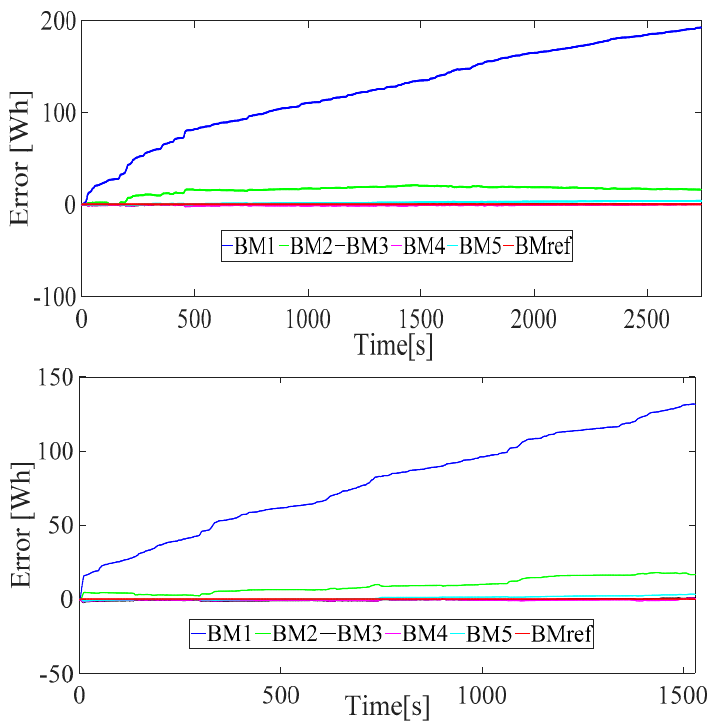
Figure 10. Error between the objective function computed by the MPC model and the reference vehicle during two UDDS ( up ) and HWFET ( down ) drive cycles.